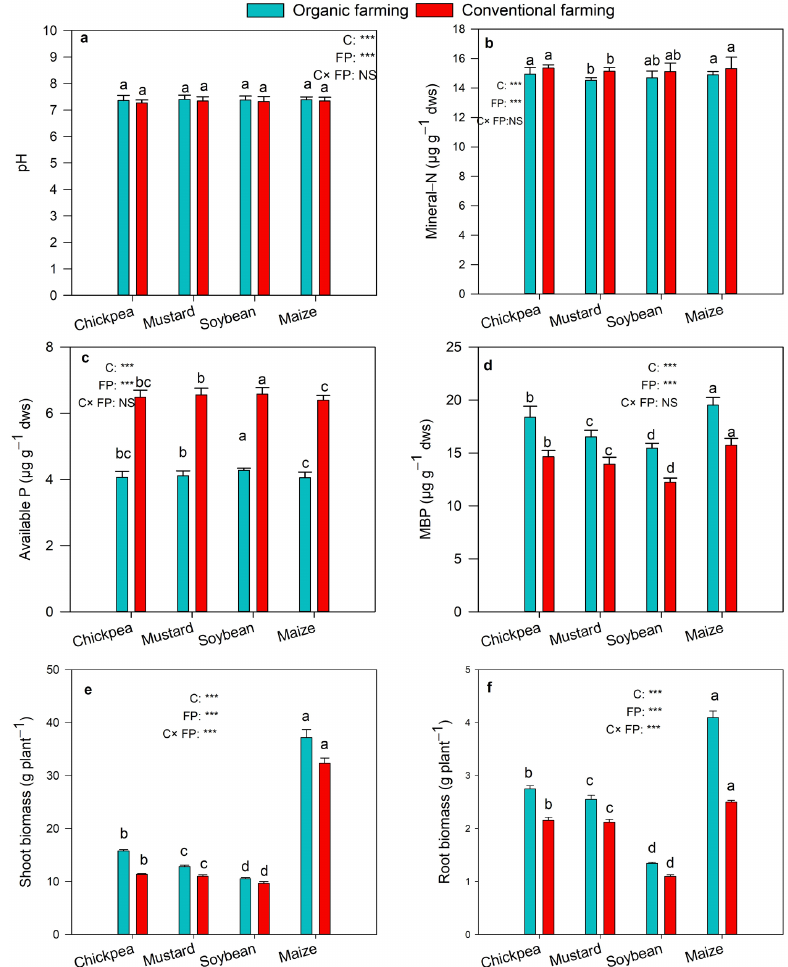
Figure 1. pH value ( a ), content of mineral-N ( b ), available P ( c ), MBP ( d ), shoot biomass ( e ), and root biomass ( f ) in organic and conventional farming. Different lowercases indicate significant differences (Tukey’s post hoc test) between crops in the same farming practice ( p < 0.05). The crops (C) and farming practice (FP) specify the results of MANOVA indicating p -value at different significance levels, *** p < 0.001, NS: not significant). The values are two-year average mean ± SD. MBP, microbial biomass P; ALP, alkaline phosphatase.